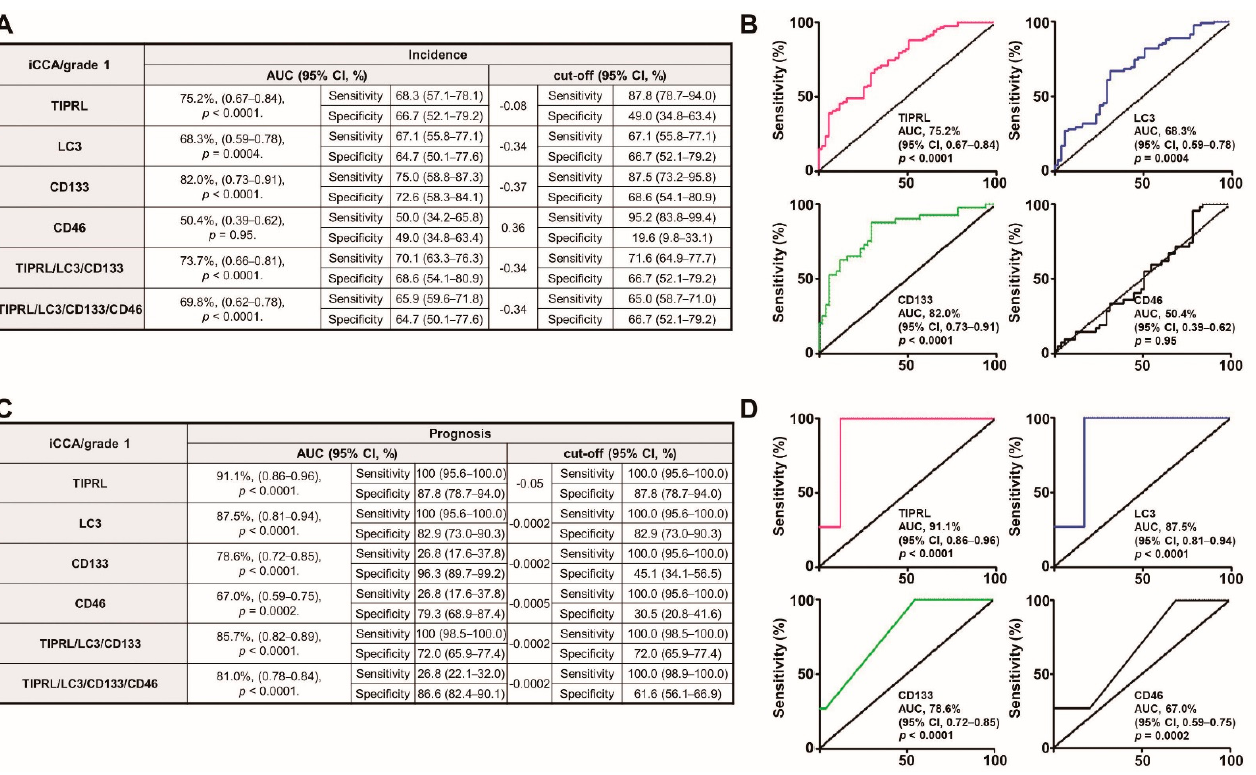
Figure 4. The significant diagnostic and prognostic efficacies of the variables, TIPRL, LC3, and CD133, excluding CD46, as a single or in conjunction for grade 1 iCCA. ( A , B ) The diagnostic and ( C , D ) prognostic potentials of the variables were determined using ROC analysis. AUC, the area under the curve, and CI, confidence interval. The number of cancer grade 1 used = 82.